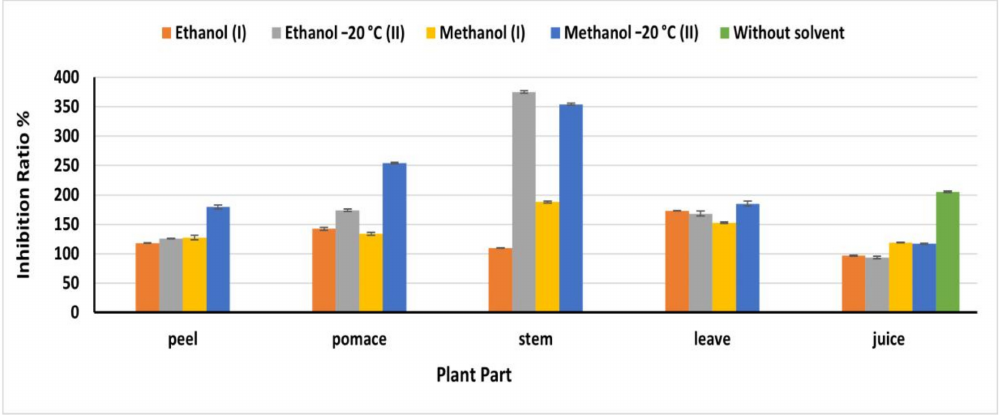
Figure 5. DPPH inhibition ratio% of beetroot extract based on the dry weight; (I): Instant Extraction method (IEM); (II): Overnight extraction method at − 20 ◦